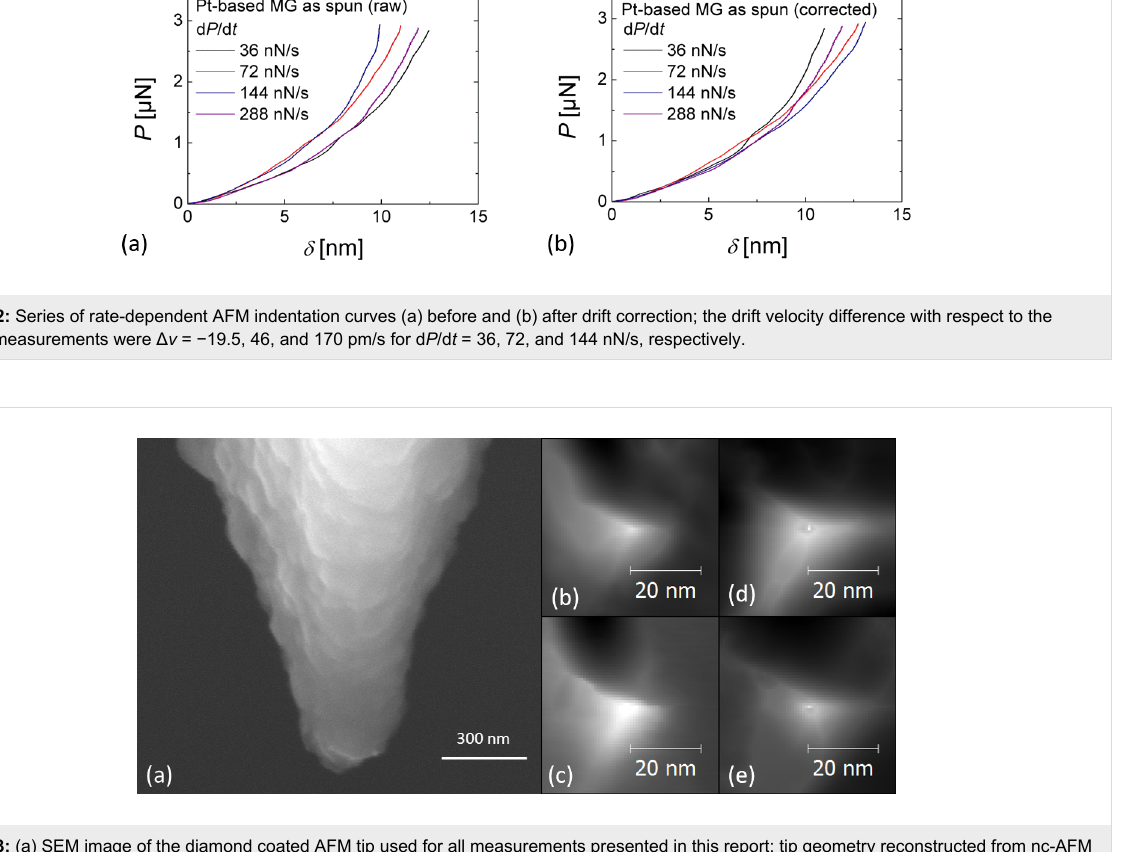
Figure 3: (a) SEM image of the diamond coated AFM tip used for all measurements presented in this report; tip geometry reconstructed from nc-AFM images on (b,c) Pt(111) ( z -scale: 5 nm) and (d,e) Pt 57.5 Cu 14.7 Ni 5.3 P 22.5 metallic glass ( z -scale: 10 nm). The nc-AFM images used to reconstruct the tip shape in (b,d) and (c,e) were recorded several months